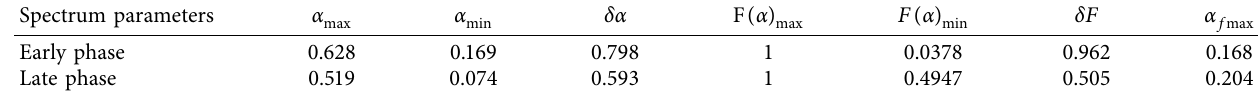
Figure 26: Hurst exponent of cylinder block nonlinear vibration. Table 8: Dimensions of multifractal global singular values and multifractal sets.